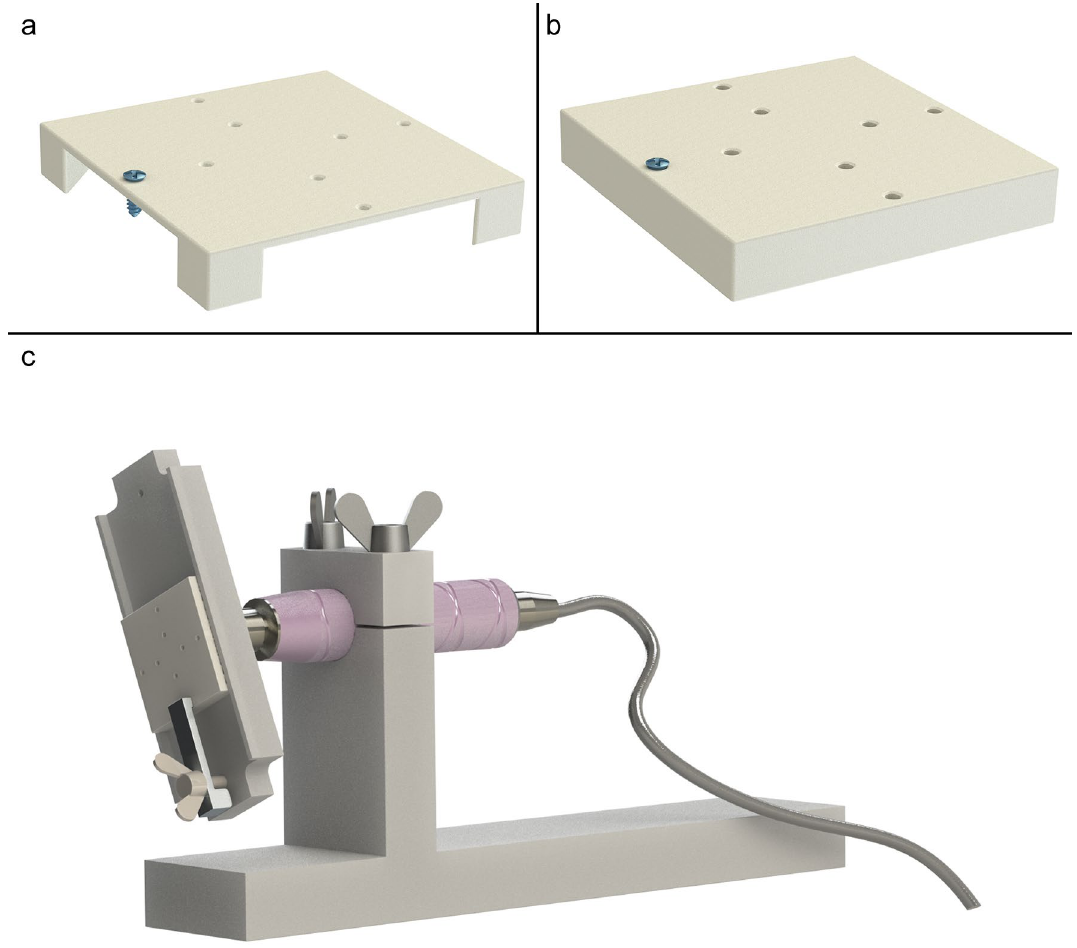
Figure 1. Example of ( a ) a high-pressure laminate (HPL) block with 1 mm thickness used for the 1.5 mm screws and ( b ) an HPL block with 6 mm thickness used for the 2.0 mm screws. Note that the screw goes through the 1 mm thick HPL plate ( a ), i.e. simulating a screw that goes through thin cortical bone (e.g., the anterior wall of the maxillary sinus) while the screw does not go through the 6 mm HPL block ( b ), i.e. simulating a bone screw in cortical bone. ( c ) The test setup with a torque meter with an inserted HPL block. The HPL-block was positioned in such a way that the screw hole of the HPL-block that was used to insert the screw was always aligned with the axis of the torque meter to ensure accurate torque